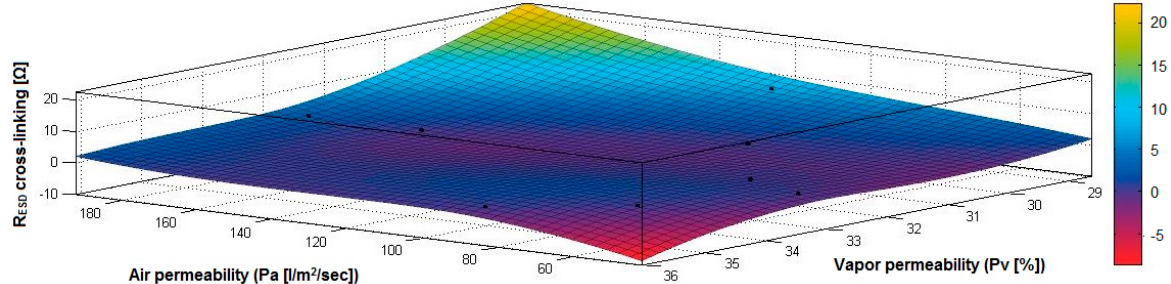
Figure 34. 3D representation R ESD after crosslinking = f(Pv, δ ) samples preliminarily treated in RF plasma O 2 using RF 2 generator and power 100 W.